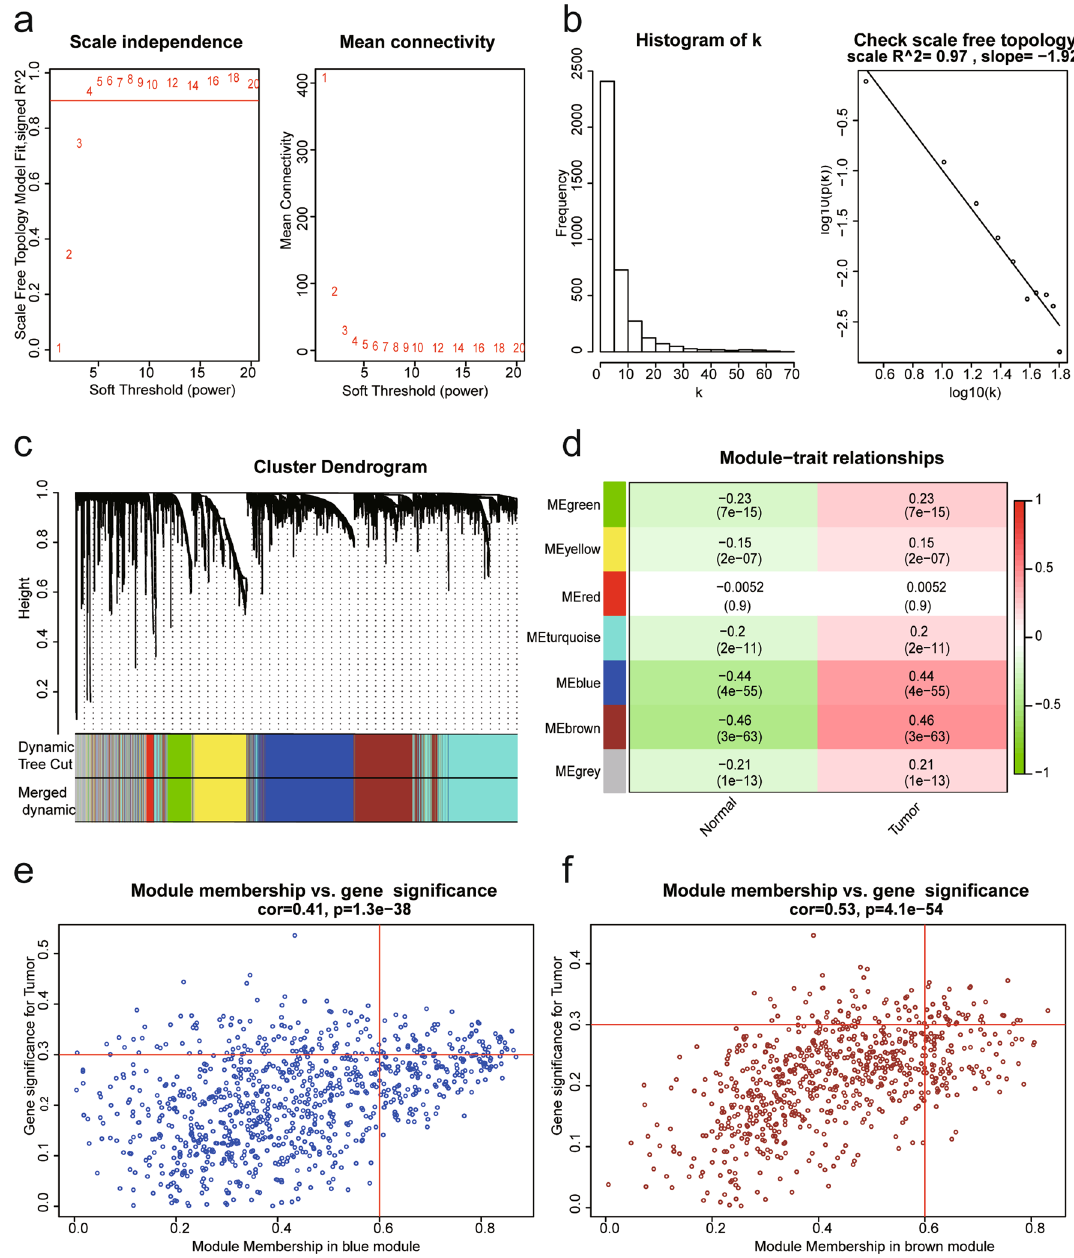
Figure 2. Identification of candidate gene modules and 102 hub genes for breast cancer based on TCGA_BRCA dataset through WGCNA. ( a) Left: analysis of the scale-free fitting indices for various soft-thresholding powers (β), red line indicated Scale Free Topology Model Fit, signed R 2 is 0.90. Right: mean connectivity analysis of various soft-thresholding powers (β value range 1–20); ( b) Left: histogram shows the frequency distribution of the k (namely connection) when β = 5. Right: checking the scale-free topology when β = 5, the figure shows that log10(k) and log10(p(k)) are negatively correlated (correlation coefficient 0.97), denoting that the gene scale- free network that we constructed is guaranteed; ( c) Clustering dendrograms of genes based on dissimilarity topological overlap calculation formula (1—TOM) and merged gene set modules. Seven weighted gene co-expression network modules were constructed and shown in different colors; ( d) Heatmap of the correlation between module eigengenes and breast cancer samples traits (Tumor). The numbers in each square of heatmap indicates the Pearson correlation coefficient (up) and P value (down); ( e) Scatter plot of gene significance for “Tumor” and module membership in the blue module. The red lines indicate MM value = 0.6 and GS value = 0.3; ( f) Scatter plot of gene significance for “Tumor” and module membership in the brow module. The red lines indicate MM value = 0.6 and GS value =